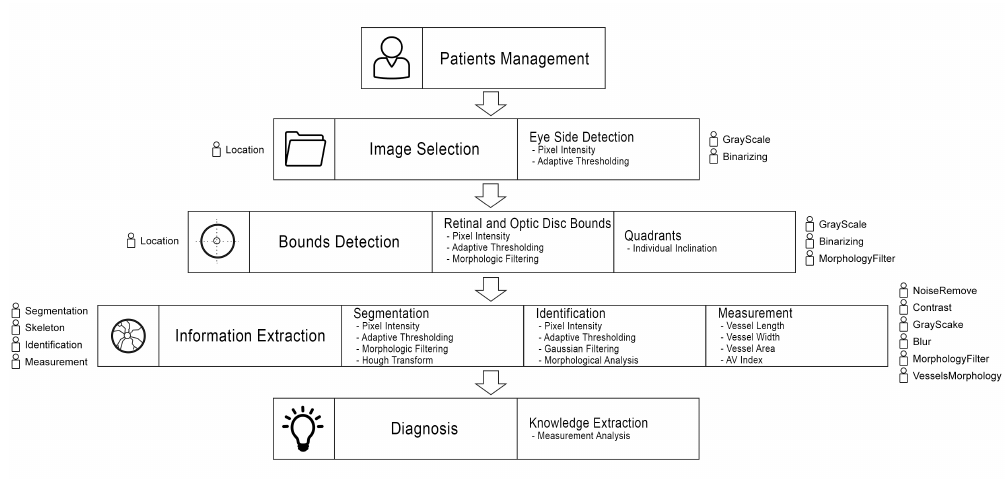
Figure 2. Stages into which the method of analysis is divided.